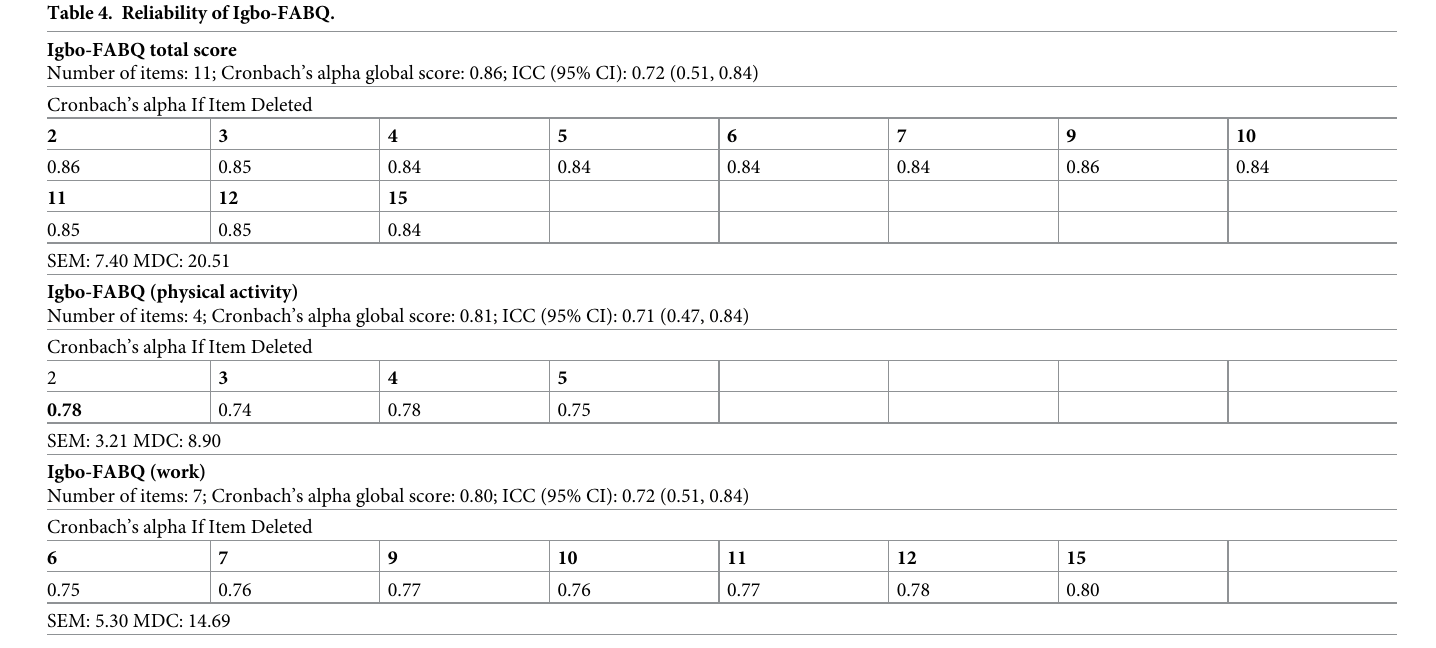
Table 4. Reliability of